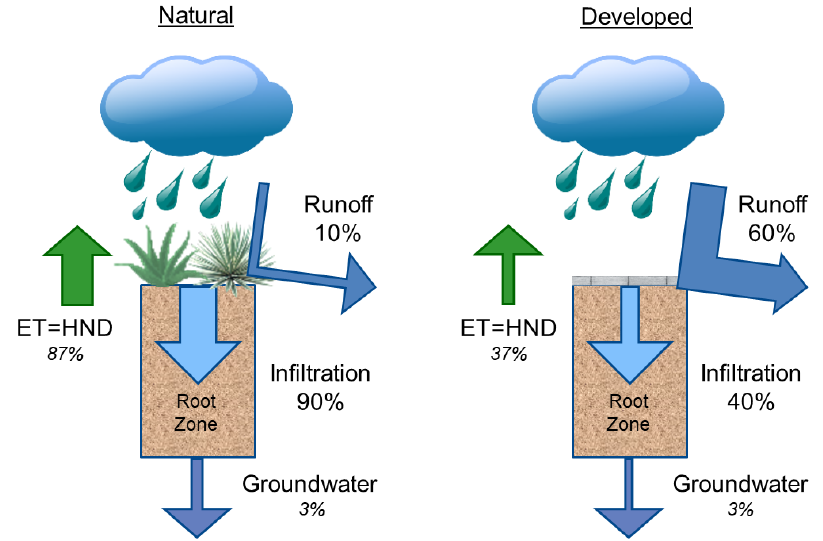
Figure 1. Water balance in natural and developed catchments. Infiltration = ET + Groundwater.